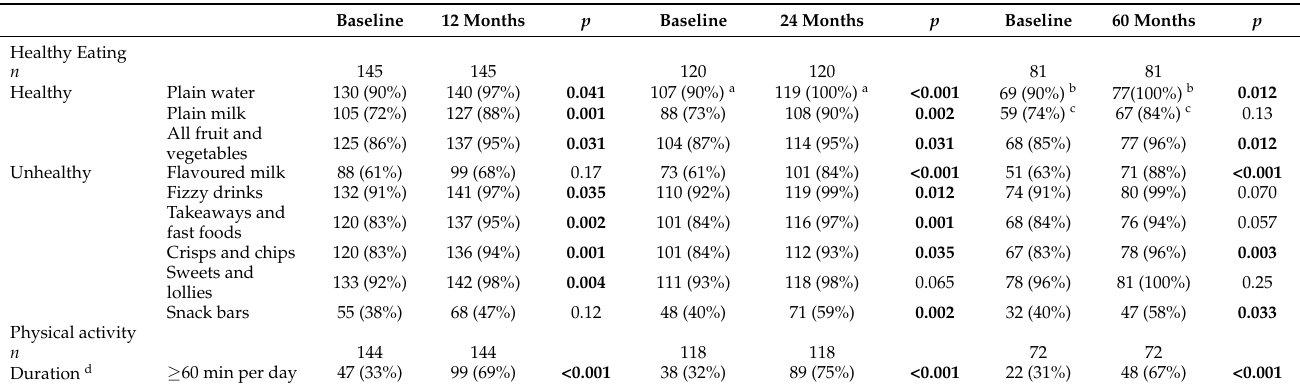
Table 2. Number and proportion of Wh¯anau Pakari participants who correctly answered the various items in the health knowledge questionnaire at the follow-up assessments compared to baseline.